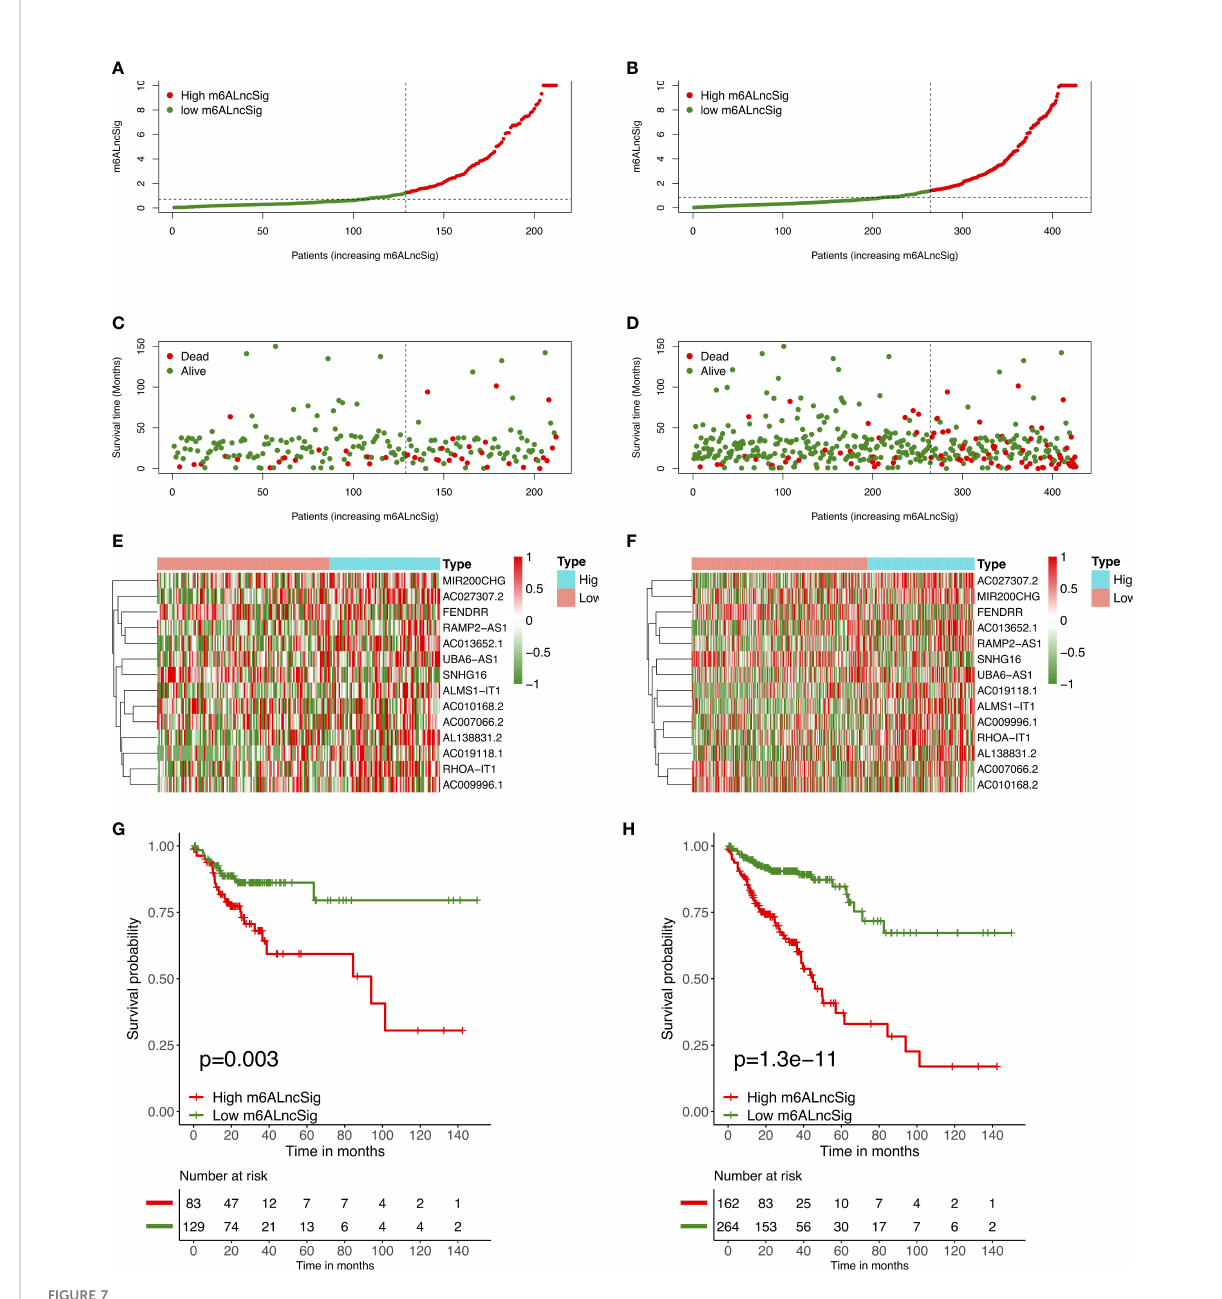
FIGURE 7 Prognostic value of m6ALncSig in the TCGA testing and entire sets. (A) Distribution of m6ALncSig-based risk score for the testing set. (B) Survival status along with survival time of COAD patients between high- and low-risk groups for the testing set. (C) Expression standards of the 14 prognostic m6A-related lncRNAs for the testing set. (D) Kaplan – Meier curves of OS in the high- and low-risk groups for the testing set. (E) Distribution of m6ALncSig-based risk score for the entire set. (F) Survival status and survival time of patients with COAD between high- and low-risk groups for the entire set. (G) Expression standards of the 14 prognostic m6A-related lncRNAs for the entire set. (H) KM curves of OS in the high- and low-risk groups for the entire